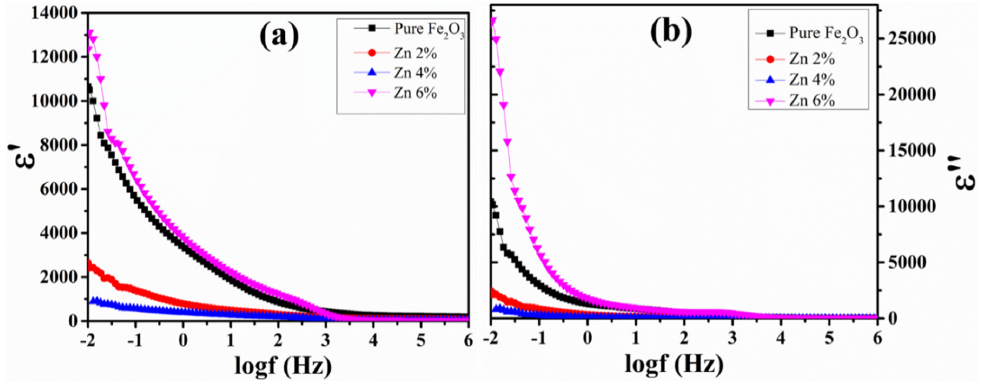
Figure 10. Variation of ( a ) real component ( ε′ ) and ( b ) Imaginary component ( ε″ ) of dielectric constant with frequency of pure Fe 2 O 3 , Zn 2%, Zn 4% and Zn 6% nanoparticles.